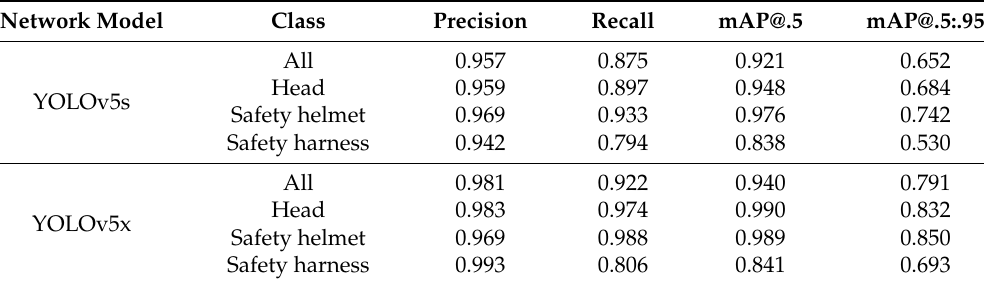
Table 1. Detection results with different pretrained